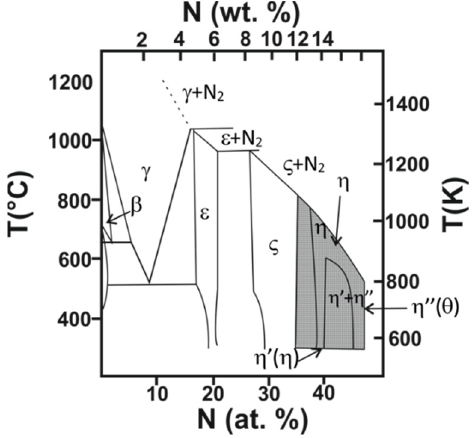
Figure 1. Binary phase diagram of Mn-N. (Redrawn with permission from Journal of Materials Chemistry; published by the Royal Society of Chemistry, 2000) [13].